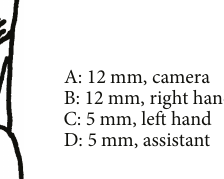
Figure 4: CT image of the tumor in the horseshoe kidney.